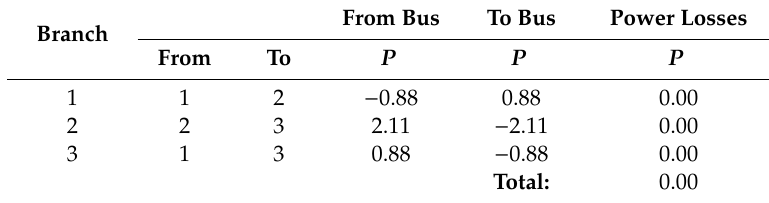
Table A25. Results of the mixed AC / DC PF calculations in Case 6-1. DC branch data.